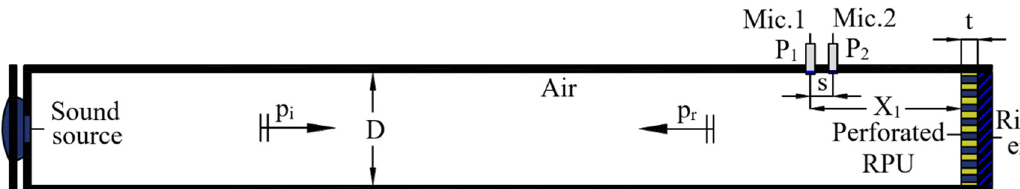
Figure 7. Diagram of the impedance tube used to measure the sound absorption at normal incidence.